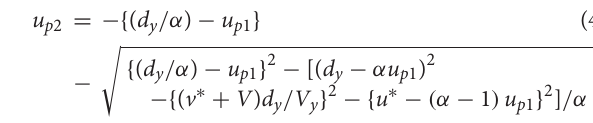
region under the first impulse. The second impulse acts before the structure goes into the unloading path naturally and experiences plastic deformation in the positive direction and then in the negative